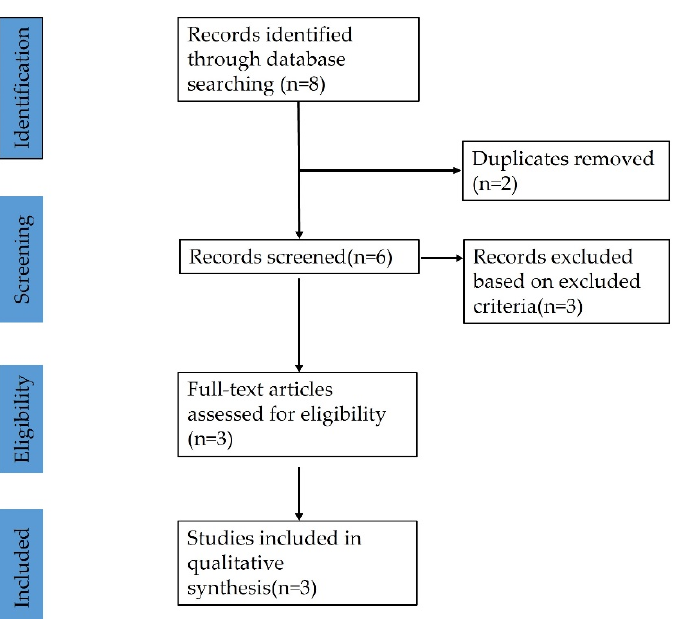
Figure 6. PRISM flowchart of the selection of the studies for this